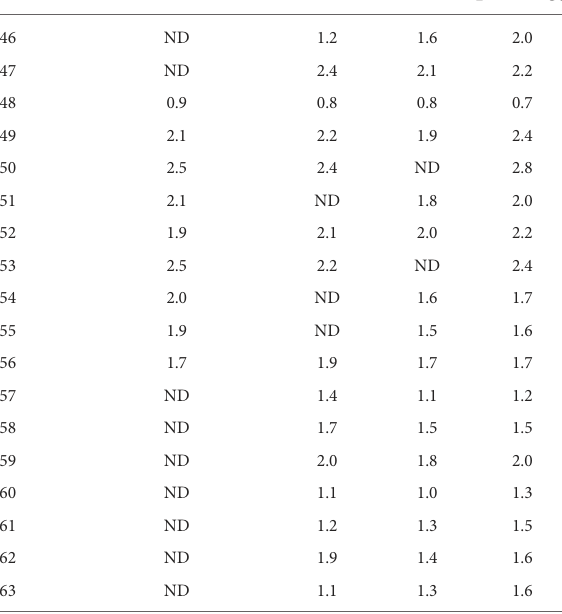
TABLE 5 Tumor size determined by mammography, sonography, MRI, and surgical pathology in patients with IMPC ( n =63).